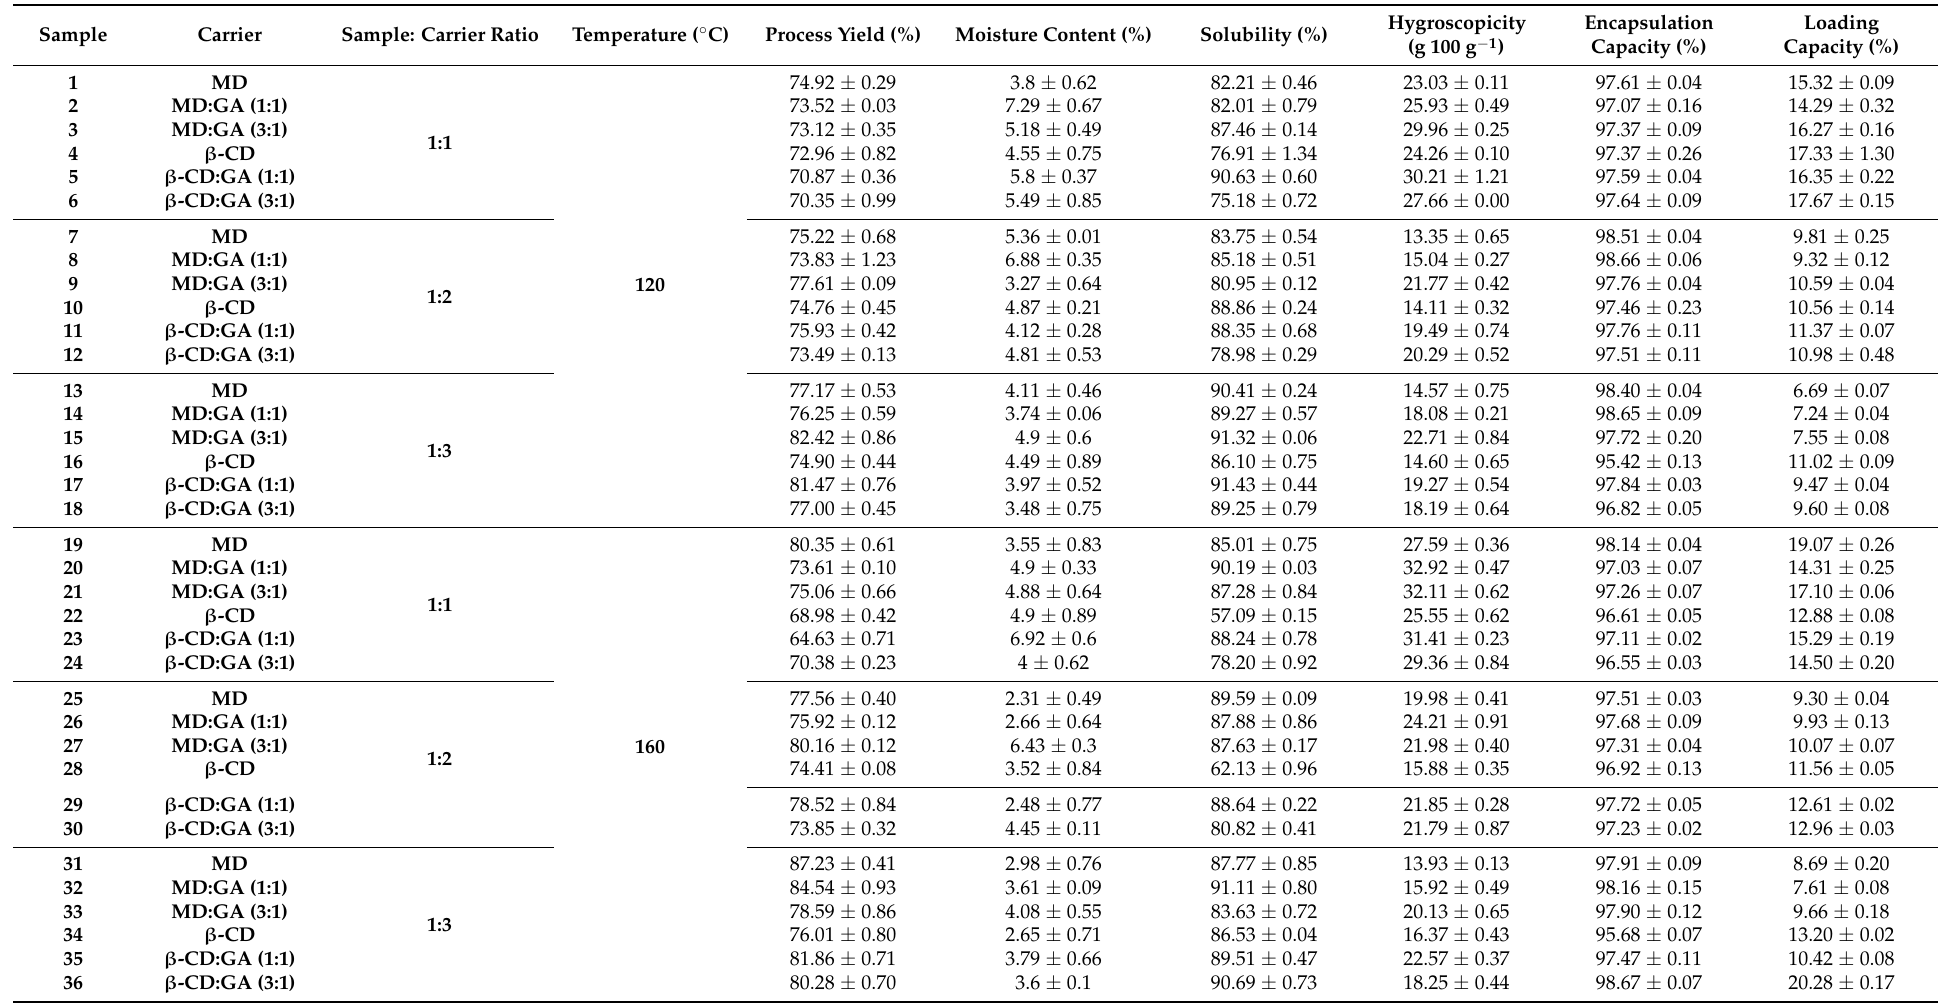
Table 1. Physicochemical properties and encapsulation capacity of nettle leaves extract powders obtained with different carrier agents added in different ratios under different